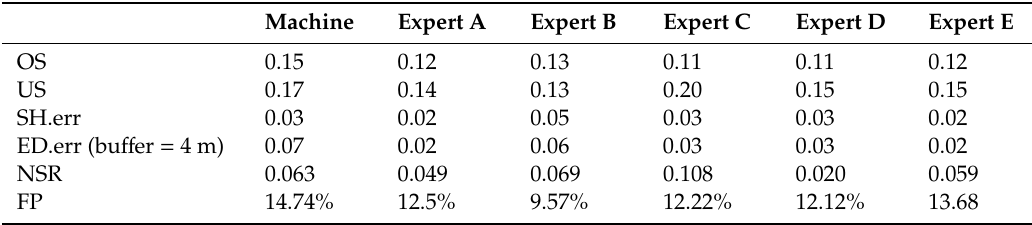
Table 3. Overall detection error by machine against humans.